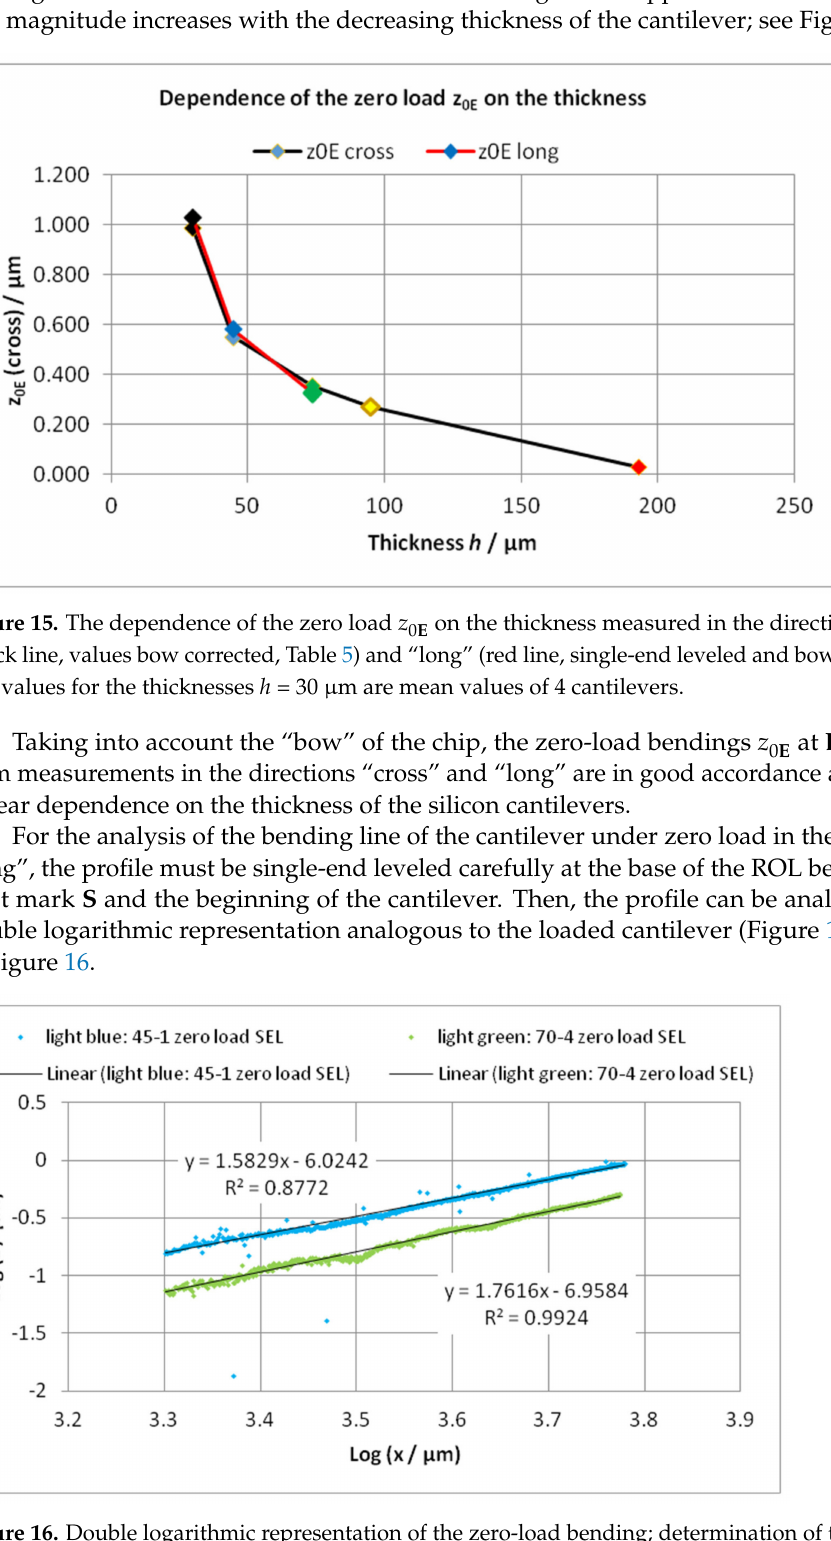
Figure 16. Double logarithmic representation of the zero-load bending; determination of the slope of the linear part (from 2000 µ m), which is the power of the bending